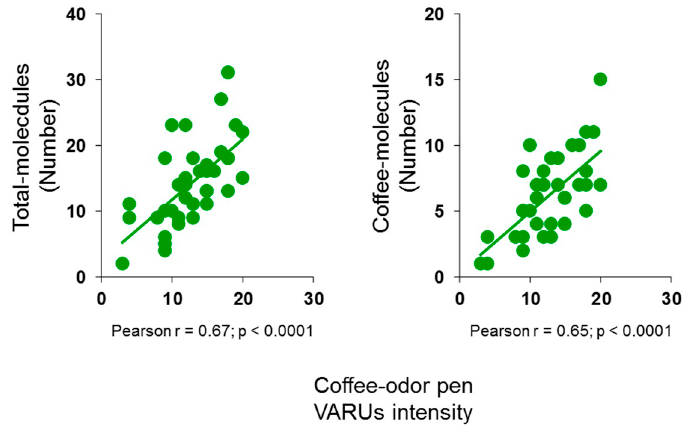
Figure 3. Correlation analysis between the number of total- and coffee-molecules smelled, and the